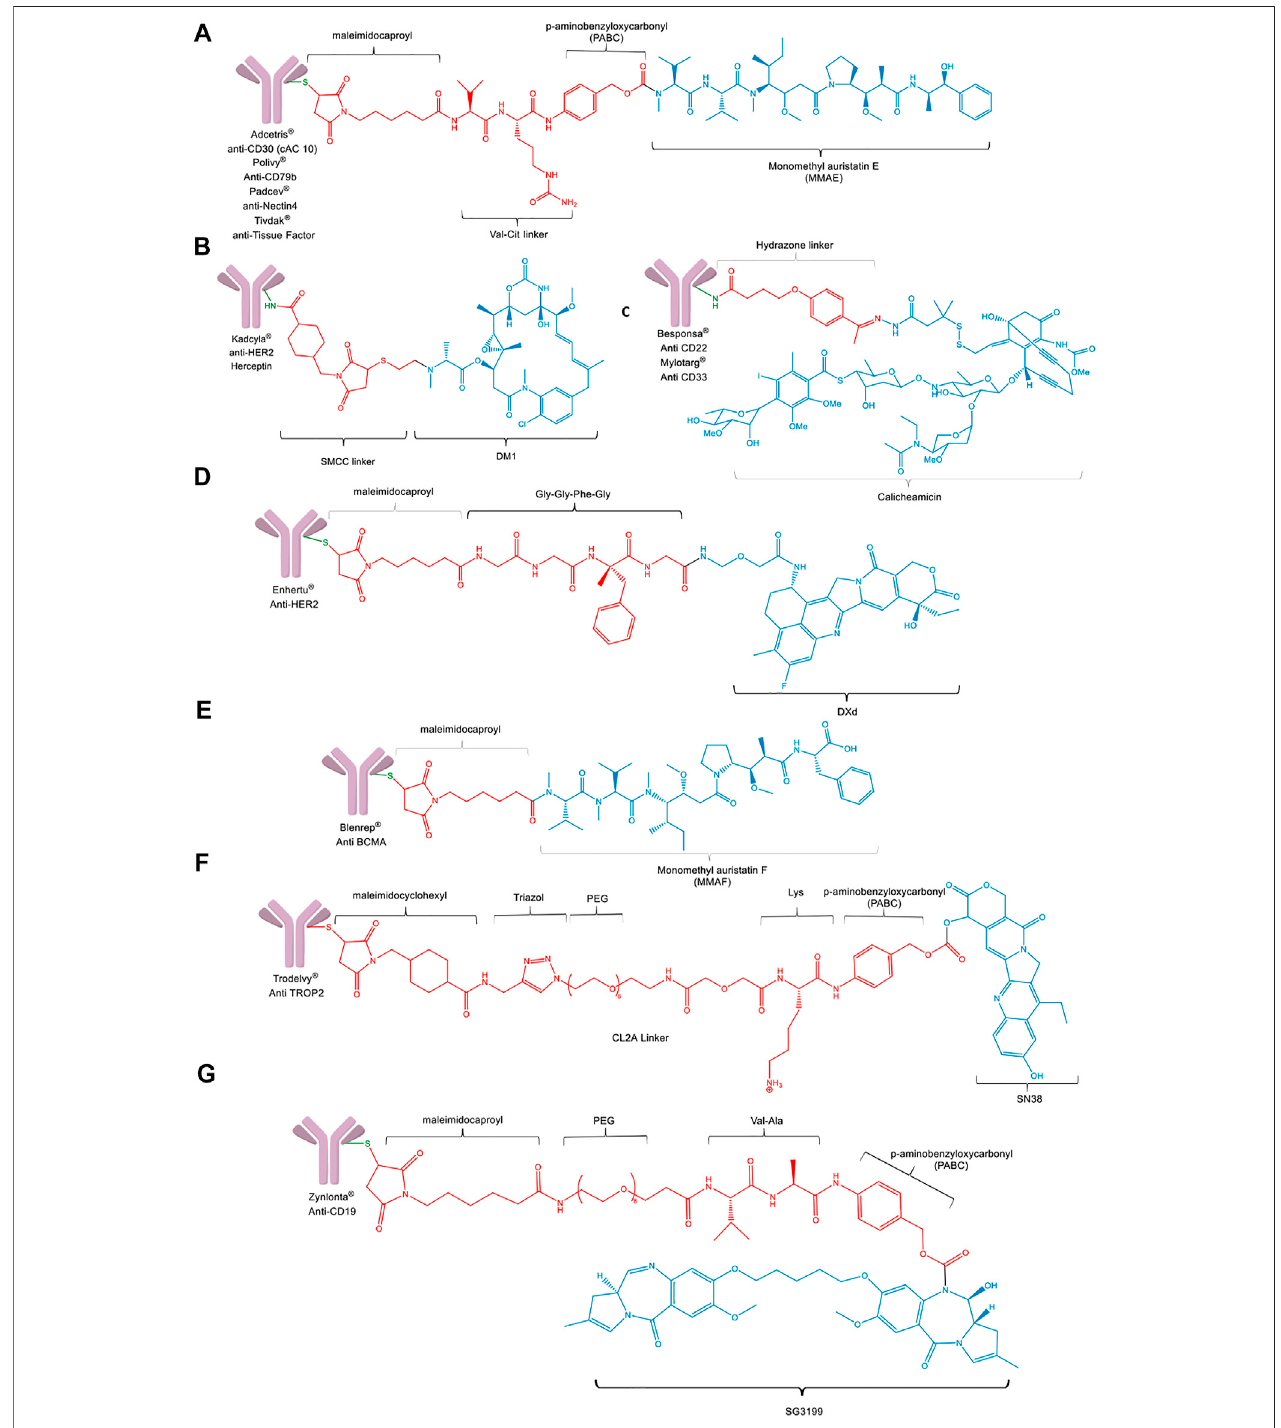
FIGURE 8 | General structures of ADC ’ are approved by the FDA. (A) Adcetris ® , Polivy ® , Padcev ® , and Tivdak ® . (B) Kadcyla ® . (C) Besponsa ® and Mylotarg ® . (D) Enhertu ® . (E) Blenrep ® . (F) Trodelvy ® . (G) Zynlonta ® . All linkers are highlighted in